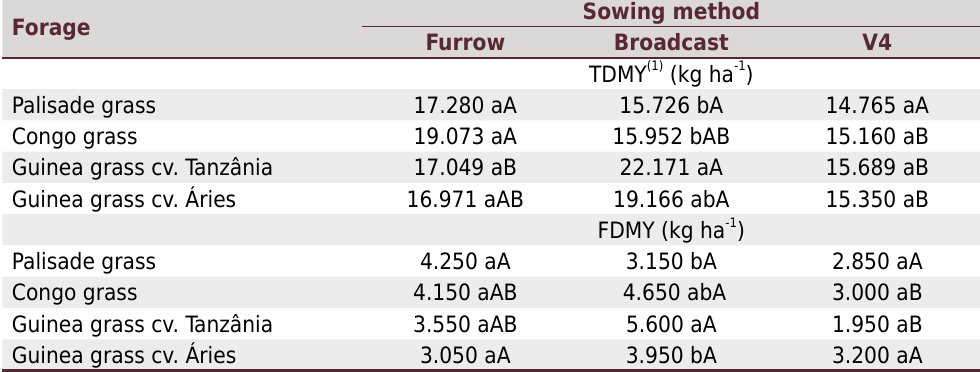
Table 2. Partitioning of significant interactions of the total dry matter yield (TDMY) of maize intercropped with forage sown in different methods and forage dry matter yield (FDMY) at the time of desiccation